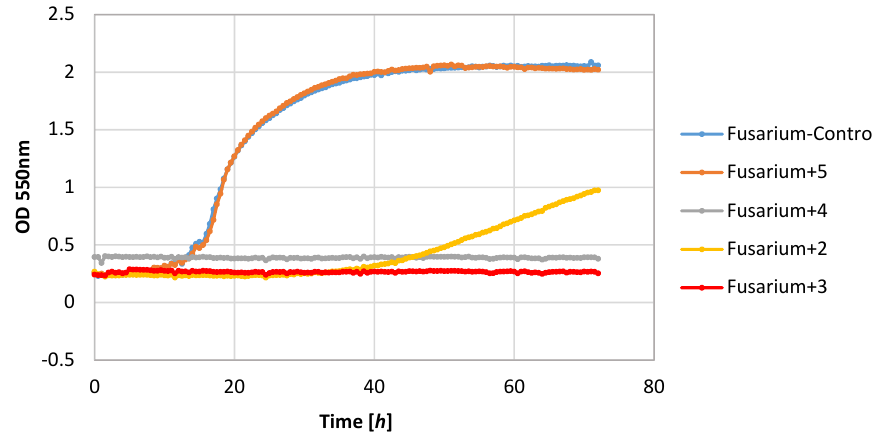
Figure 3. The assessment of the effects of the lactones 2 – 5 on the growth of F. linii. (OD-Optical Density was measured for λ 550 nm).